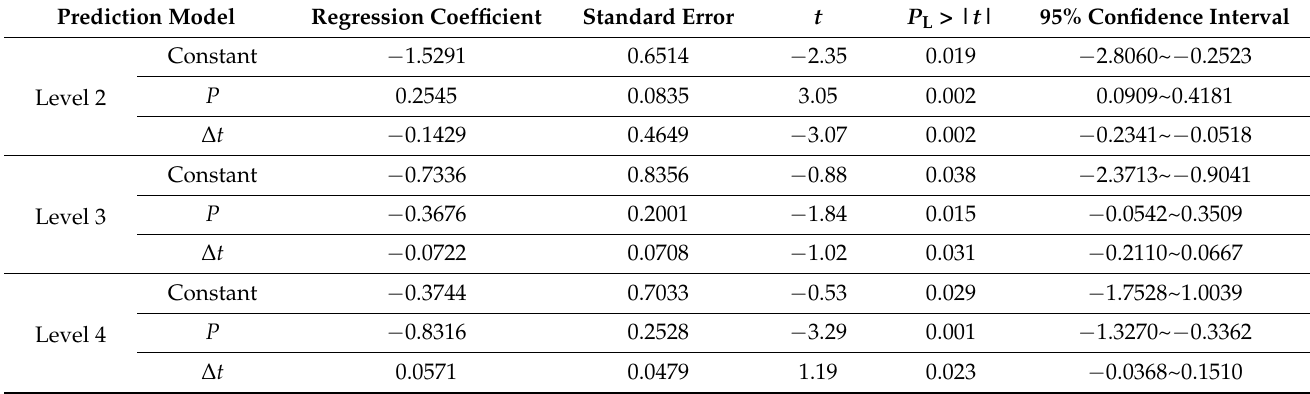
Table 7. Results of the logistic regression analysis on a dry